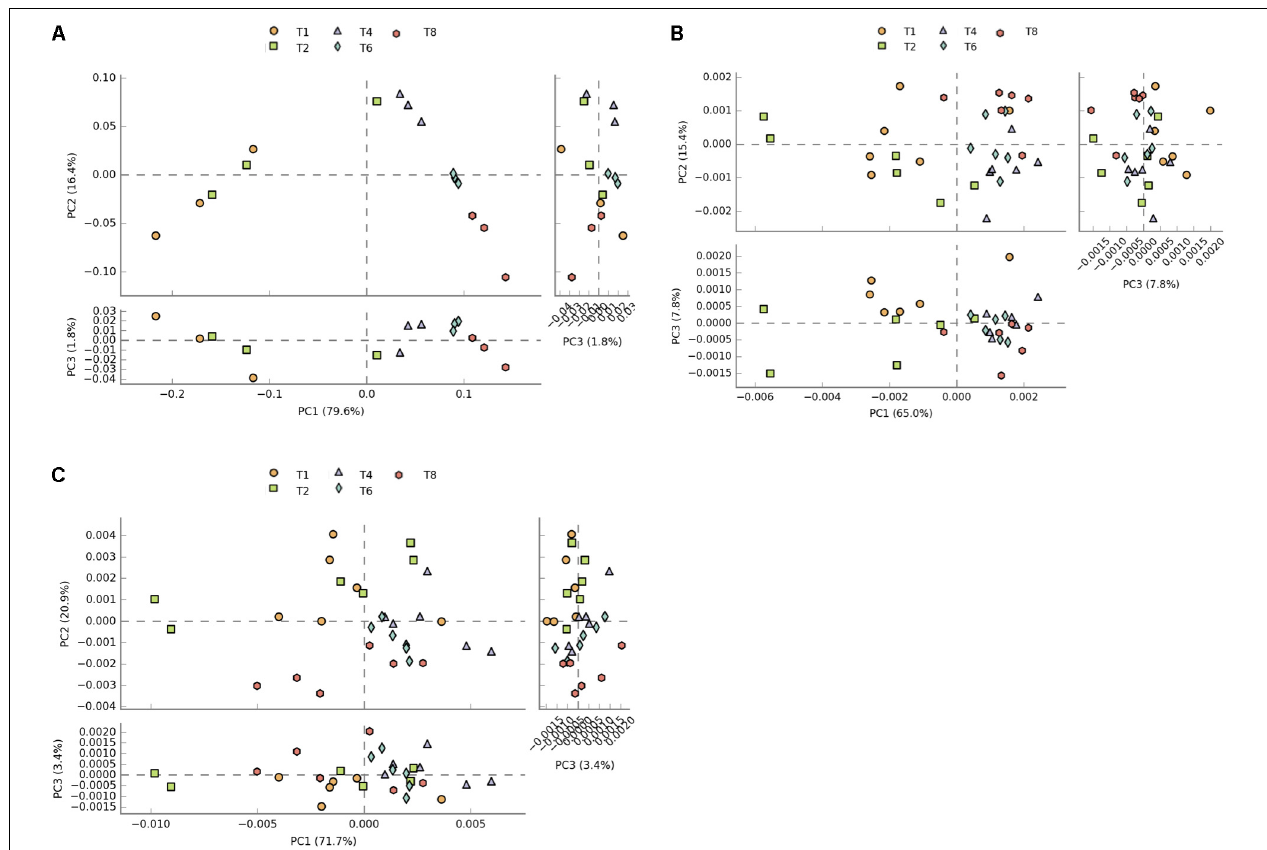
FIGURE 2 | Plots of principal components of distances between sample pathway profiles. (A) PC1 accounts for 79.6% and PC2 16.4% of the variation between samples in the transcriptome dataset. (B) PC1 accounts for 65% and PC2 for 15% of variation in the PICRUSt predicted pathways. (C) For the CowPI predicted pathways, PC1 represents 71.7% of the variation and PC2,